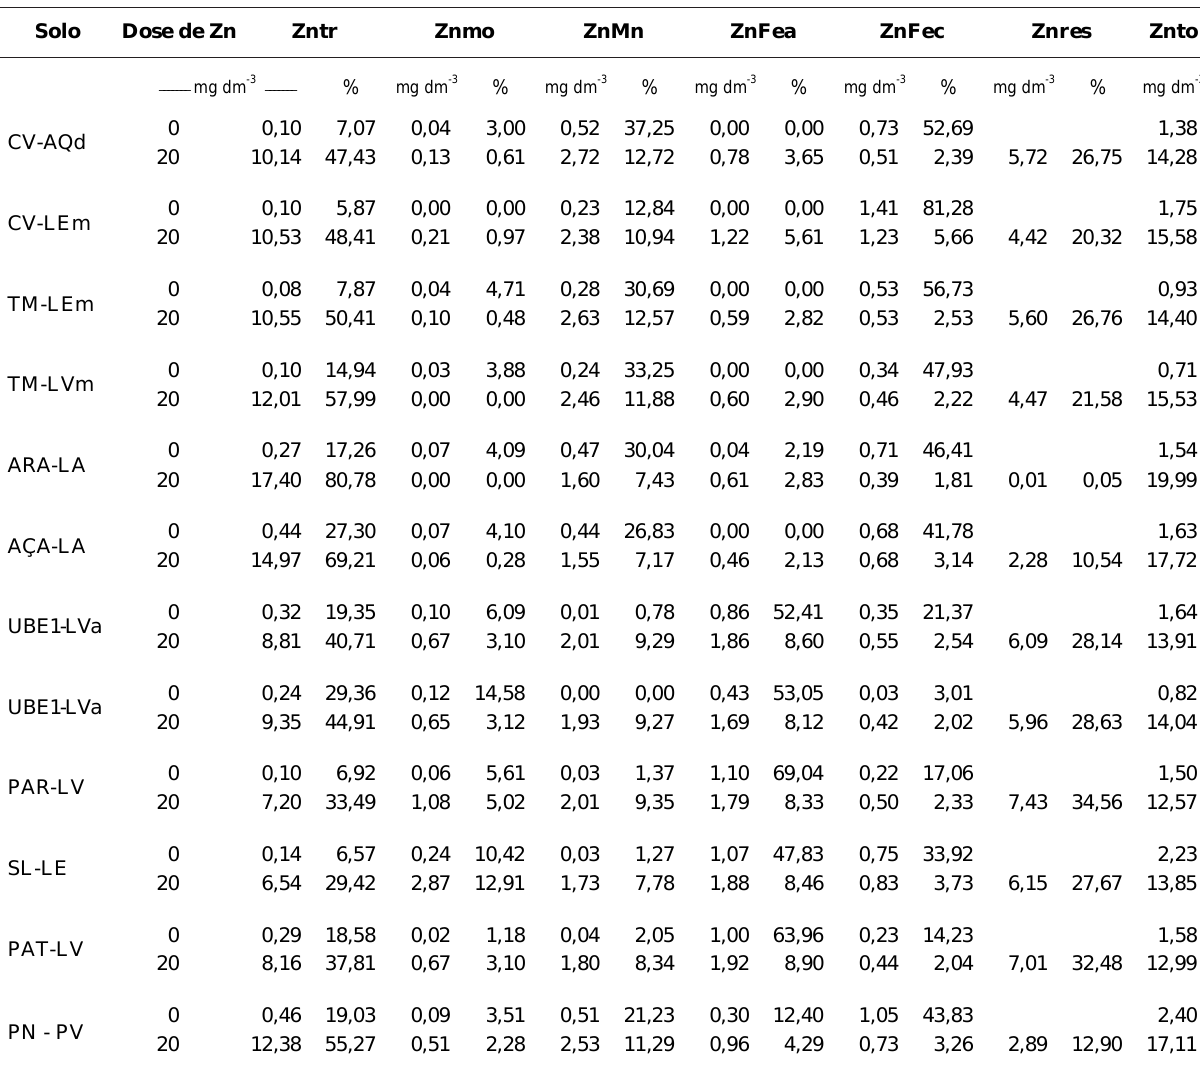
Quadro 5. Frações de zinco: Zn trocável (Zntr), ligado à matéria orgânica (Znmo), ligado a óxido de manganês (ZnMn), ligado a óxido de ferro amorfo (ZnFea), ligado a óxido de ferro cristalino